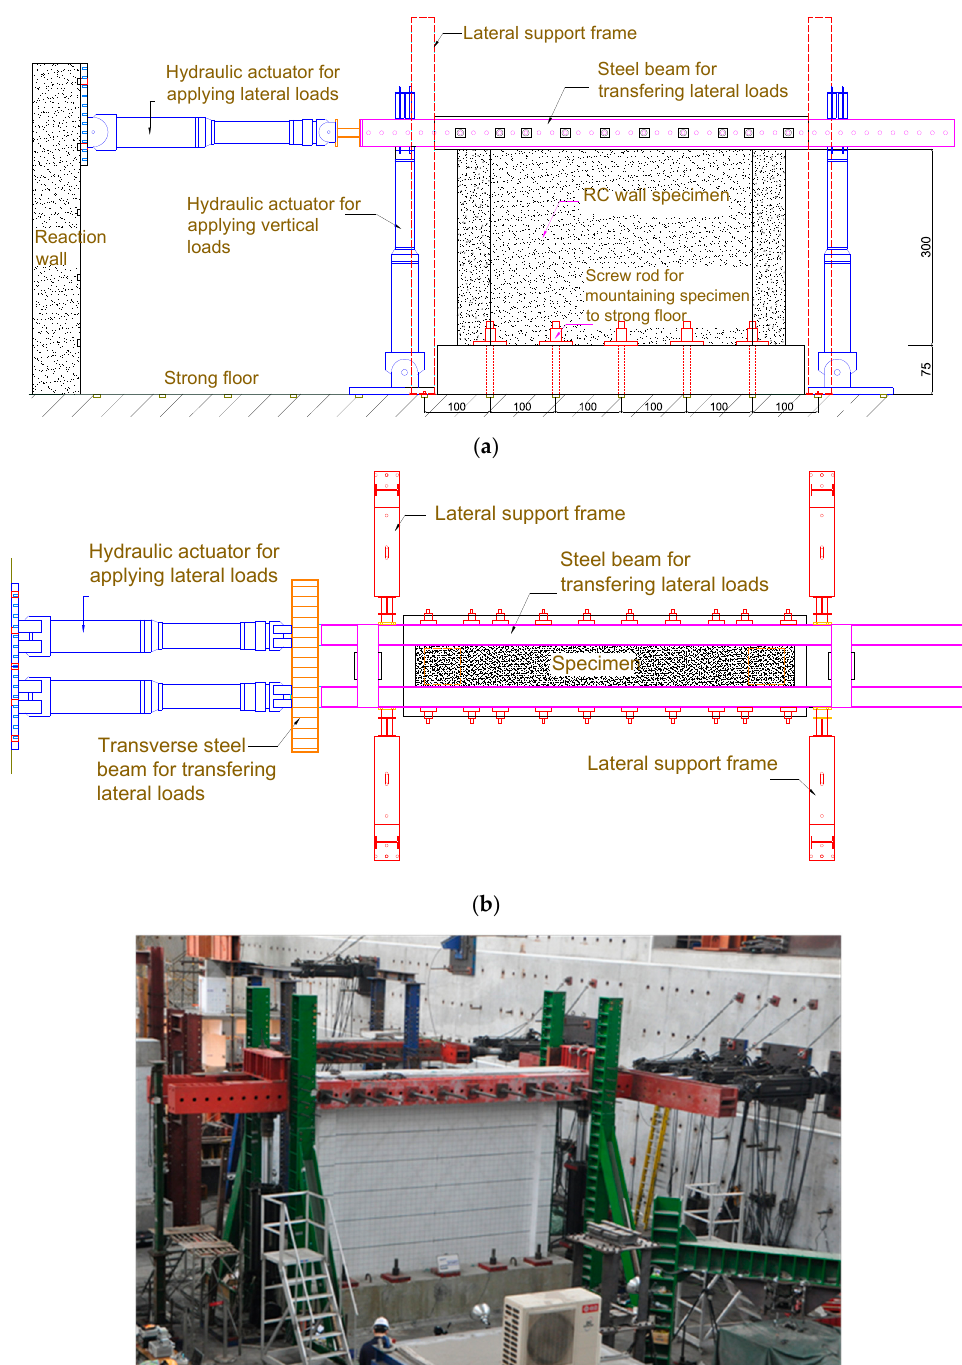
Figure 5. Experimental set-up of the cyclic loading test, ( a ) lateral view, ( b ) top view and ( c ) the photo.